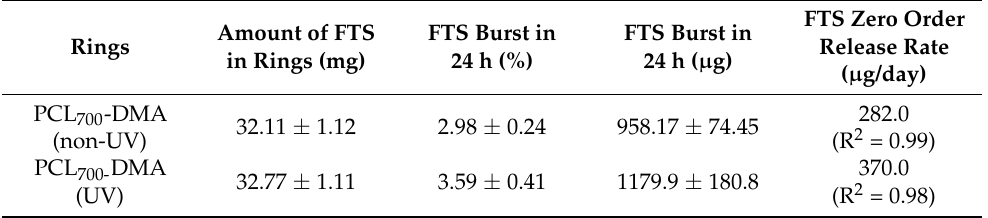
Table 5. Total amount of FTS in rings normalized to the weights of rings (n = 3), release rate of FTS at zero order kinetics ( µ g/day).